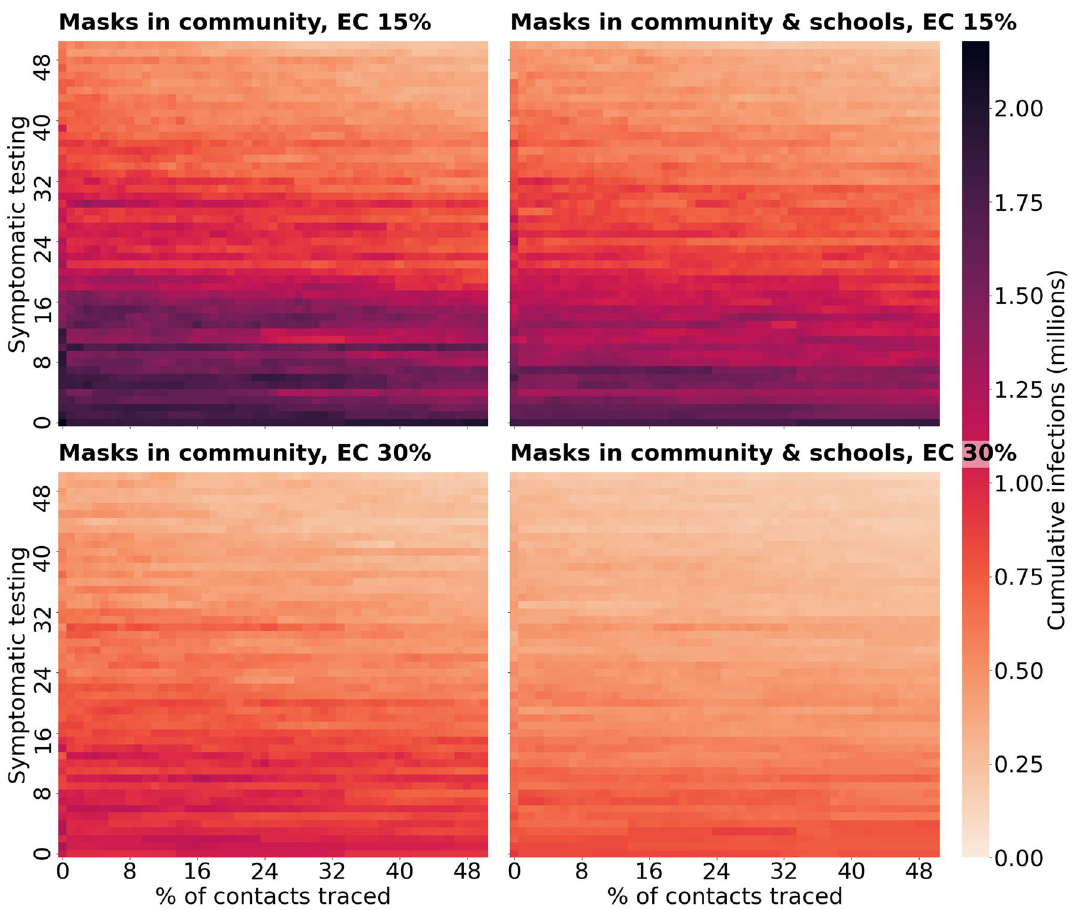
Figure 2. Heatmaps of cumulative infections for different trace (x-axis) and test (y-axis) levels across the scenario of mask wearing in parts of community with and without schools masks’ wear. Higher cumulative infections are shown in darker shades of red, while lower values are lighter colours. The region of a light orange colour where cumulative infections remain below 500,000, represents a region within where the second wave of COVID-19 after September 2020 is avoided with combinations of adequate test-trace and mask